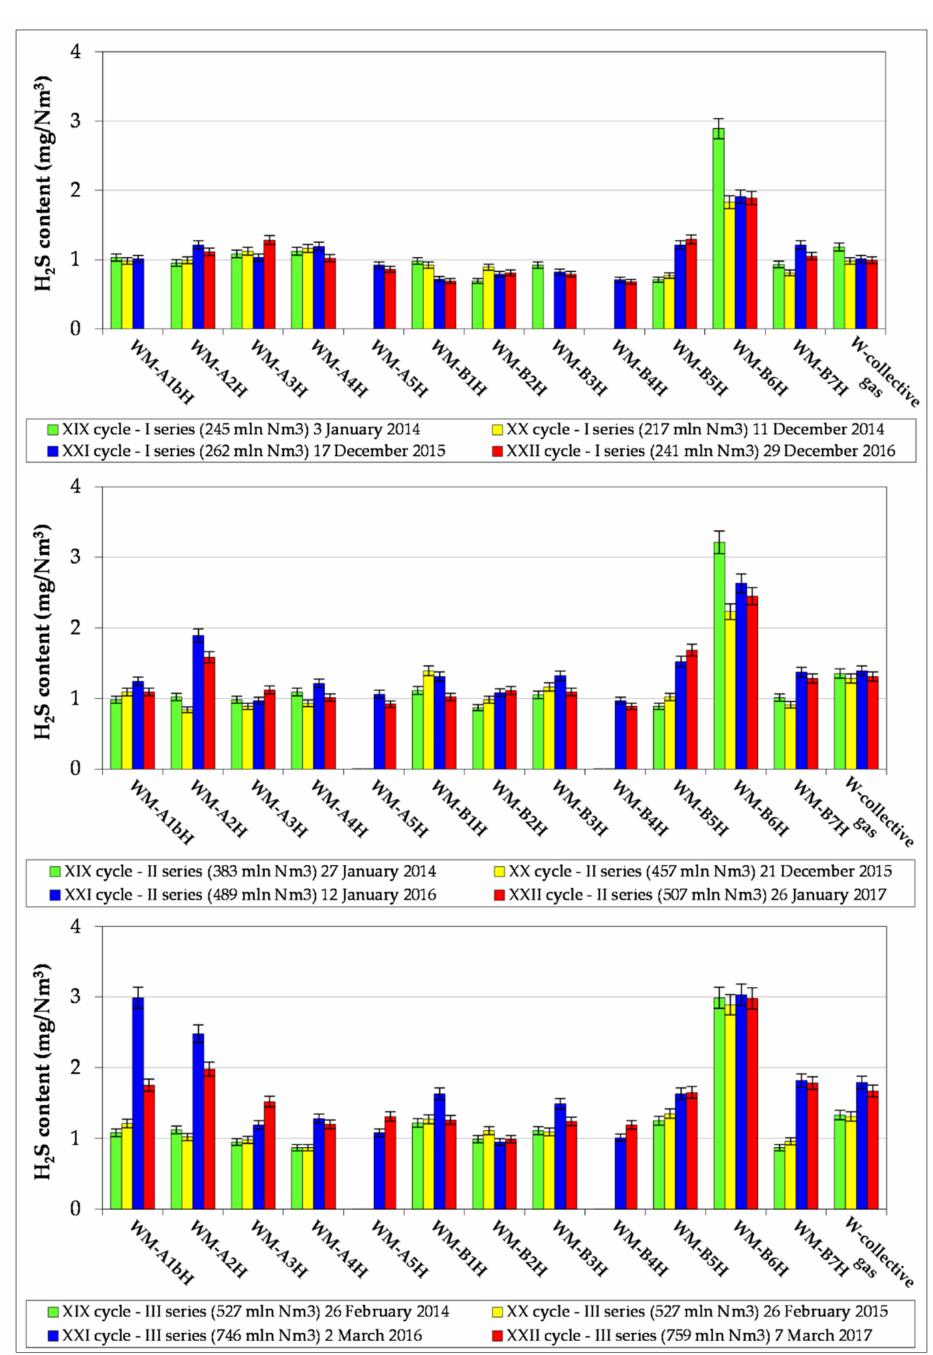
Figure 3. A comparison of hydrogen sulphide content in gas from operational horizontal wells in clusters A and B of the Wierzchowice Underground Gas Storage facility (series